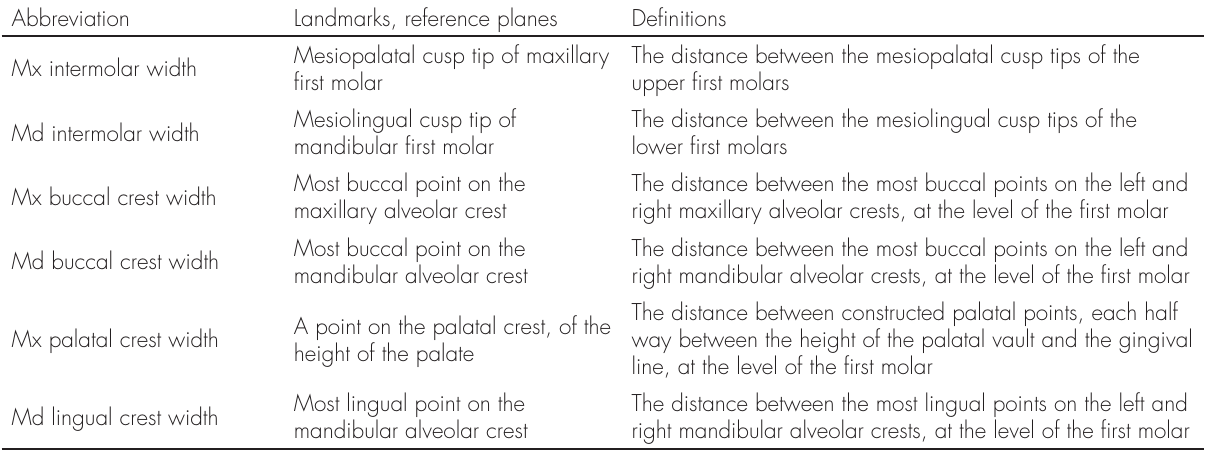
Table III. Dental arch-width